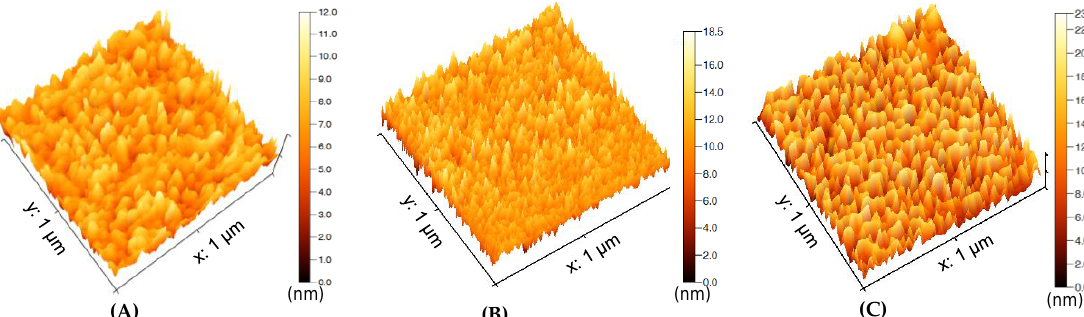
Figure 4. AFM analysis of bare ( A ), GQD-laminated ( B ), and antibody-immobilized ( C ) sensor surfaces. Eight Y. enterocolitica samples (1 – 6.23 × 10 8 cfu mL − 1 ) were prepared in PBS buffer (pH 7.4). These